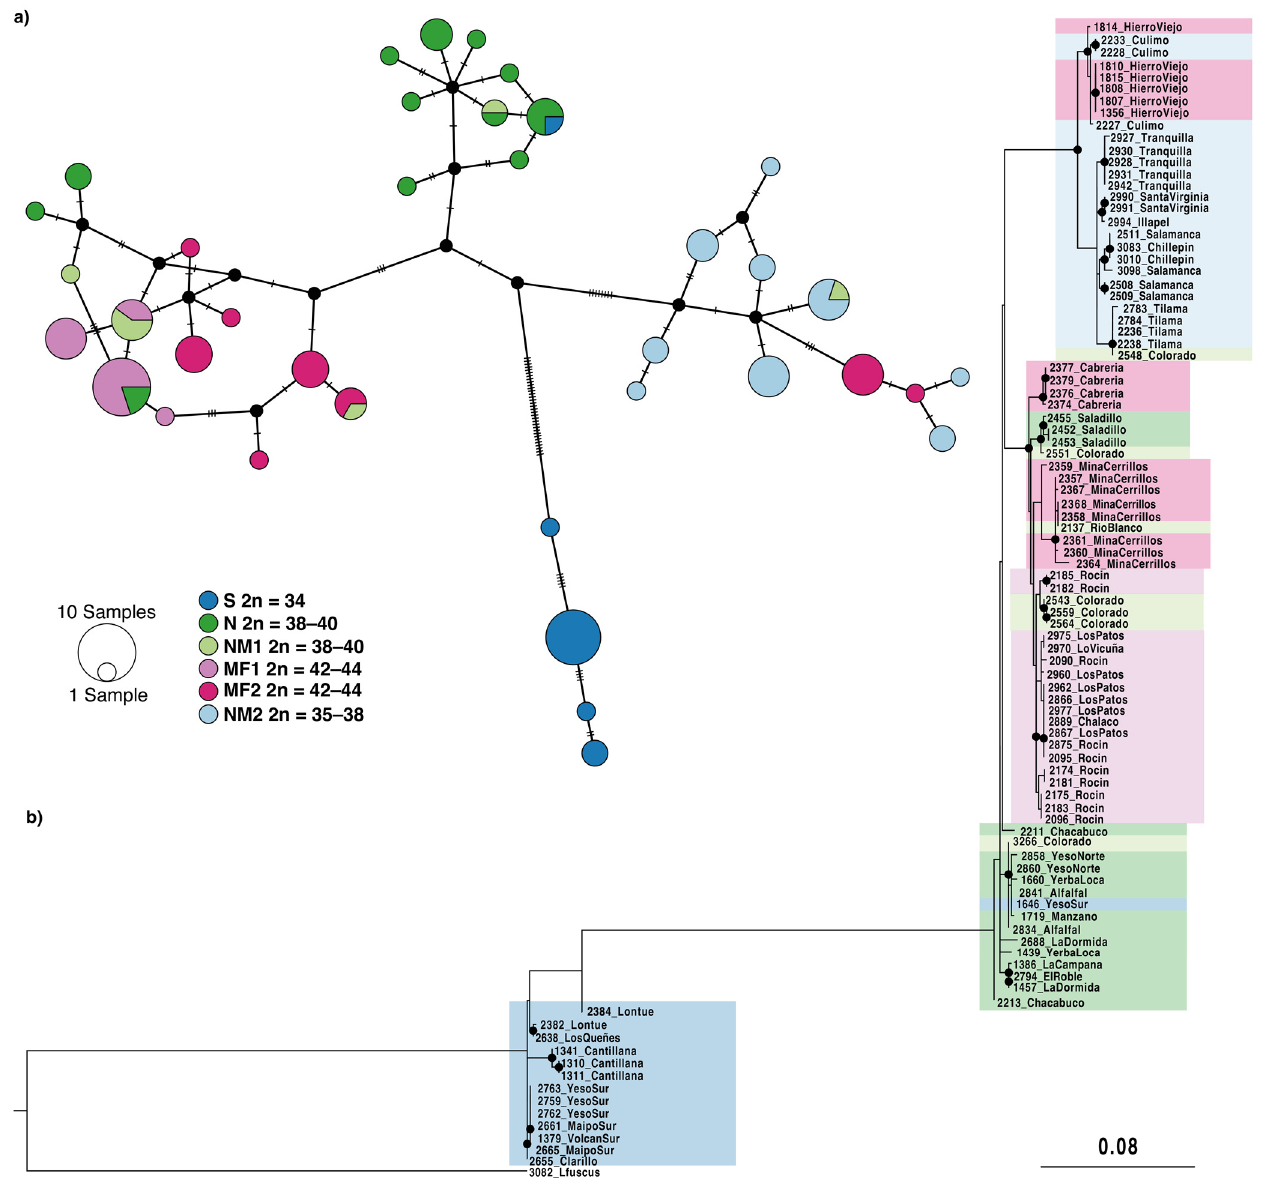
Figure 5. ( a ) Neighbor-joining haplotype network generated from the mitochondrial cytb gene with new and previously obtained sequences of L. monticola. Each line indicates a mutational step. ( b ) Maximum likelihood phylogenetic reconstruction for the cytb gene. Nodes with black filled circles indicate >70% bootstrap support. Note the presence of individuals with discordant positions in both analysis. Table 5. Genetic variability of cytb in the Liolaemus monticola chromosome race samples (S: Southern; N: Northern; NM1: Northern Modified 1; MF1: Multiple Fissions 1; MF2: Multiple Fissions 2; NM2: Northern Modified 2). Sample size (n), number of haplotypes (K), number of segregating sites (S), haplotype diversity (H), nucleotide diversity ( π ), and Tajima’s D statistic for each L. monticola chro-